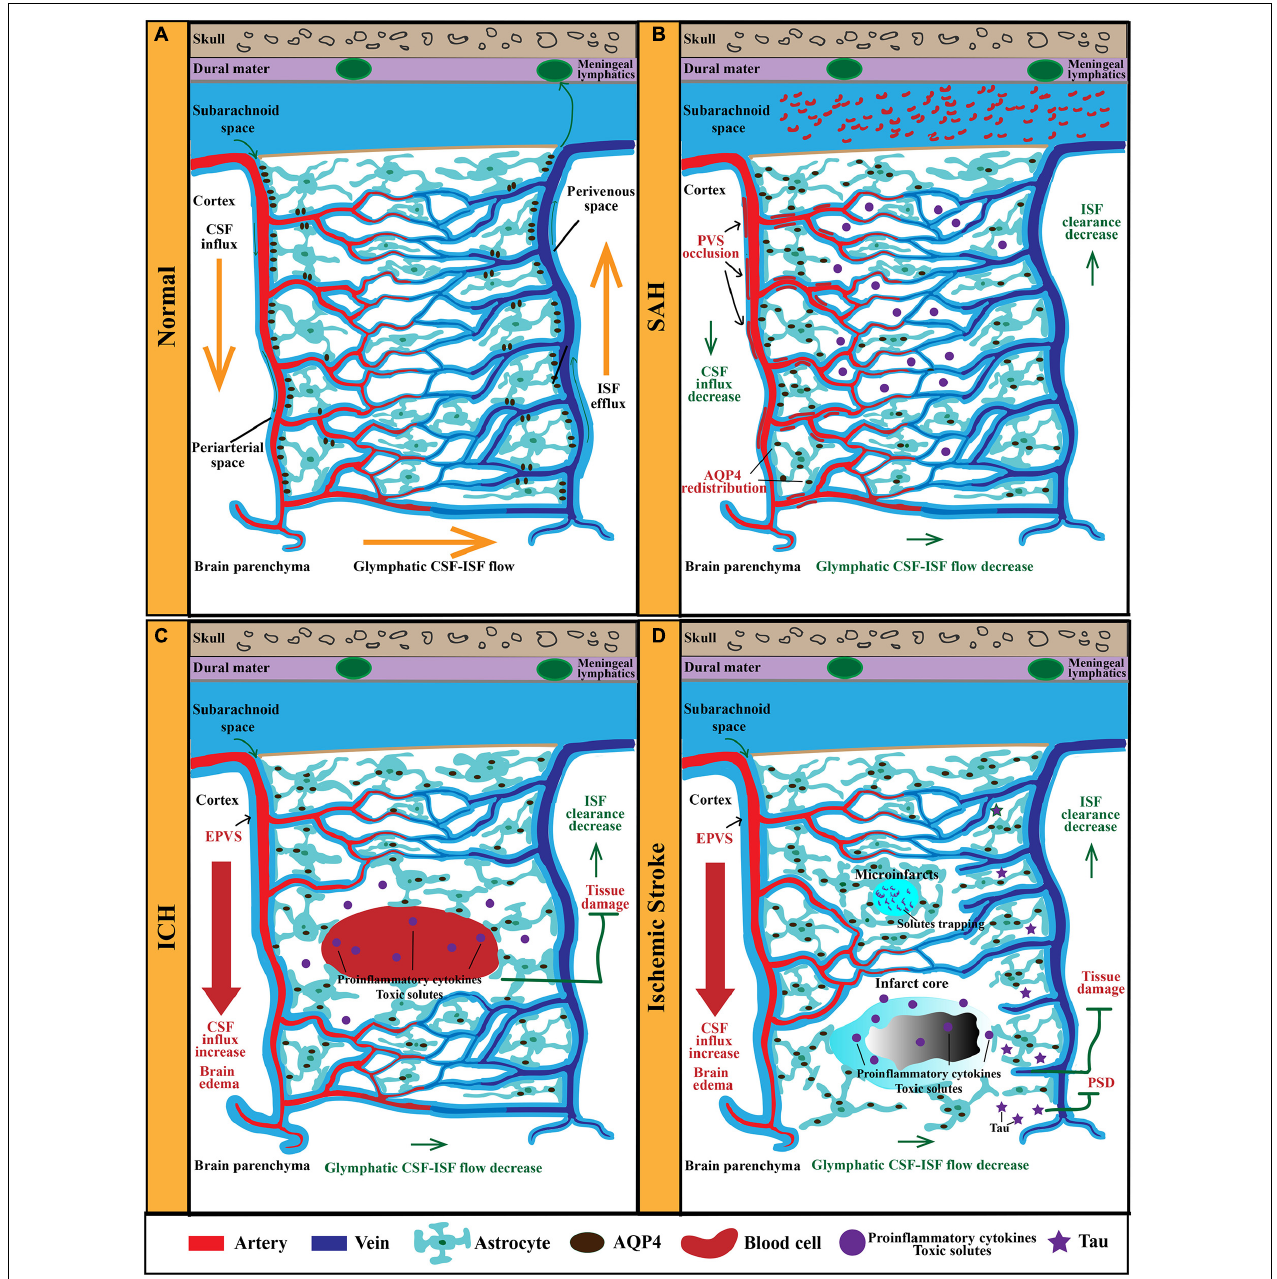
FIGURE 1 | The anatomy and function of the GS in physiological and pathological conditions. (A) The GS mainly consists of periarterial CSF-inflow channel, perivenous ISF-outflow channel, and astrocytes-mediated convective transport of fluid and solutes. AQP4 polarized on astrocytic end-feet facilitates fluid and solutes exchange between the CSF and the brain interstitium. In physiological condition, CSF from the subarachnoid space is propelled into the brain parenchyma via the PVS of penetrating arteries. Then, CSF exchange with ISF in the extracellular space. Afterward, ISF and solutes move toward the perivenous space, ultimately drain out of the CNS via meningeal lymphatics. (B) After SAH, blood components invade the PVS rapidly, resulting in PVS occlusion and reduced CSF influx and ISF clearance. Furthermore, the perivascular polarity of AQP4 decreases after SAH, which resulted in accumulation of proinflammatory cytokines and neurotoxic solutes. In addition, AQP4 in the influx routes is upregulated markedly, while that in the efflux routes changes slightly. (C) In models of ICH, PVS is enlarged and responsible for brain edema. EPVS is also an independent risk factor for ICH recurrence. Moreover, glymphatic clearance rate is reduced, which contributes to the accumulation of proinflammatory cytokines and neurotoxic solutes. (D) In models of ischemic stroke, the ischemic spreading depolarizations along with subsequent vasoconstriction result in EPVS and doubled glymphatic inflow speeds. The increased influx of CSF in the GS contributes to poststroke edema. Additionally, the GS dysfunction after ischemic stroke impedes the clearance of neurotoxic solutes, proinflammation cytokines, and tau, which results in tissue damage and PSD. GS, glymphatic system; CSF, cerebrospinal fluid; ISF, interstitial fluid; PVS, perivascular space; CNS, central nervous system; SAH, subarachnoid hemorrhage; ICH, intracerebral hemorrhage; PSD, poststroke